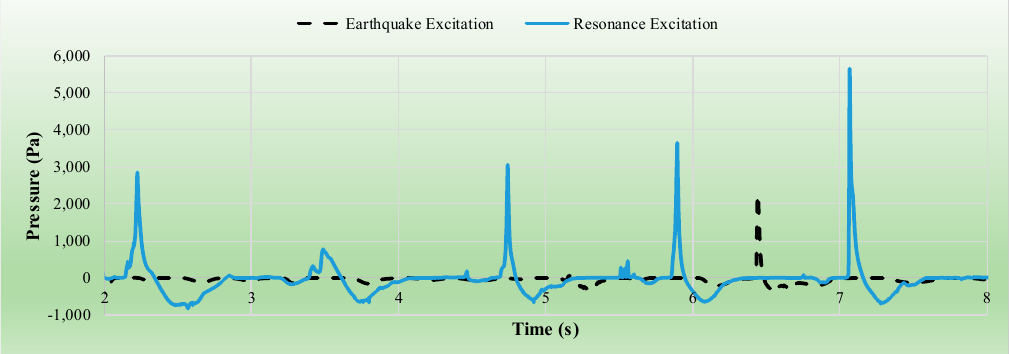
Figure 16. Comparison of maximum pressure caused by earthquake and resonance excitations (sensor location Q) at 30° orientation for tank with 200 mm water depth.